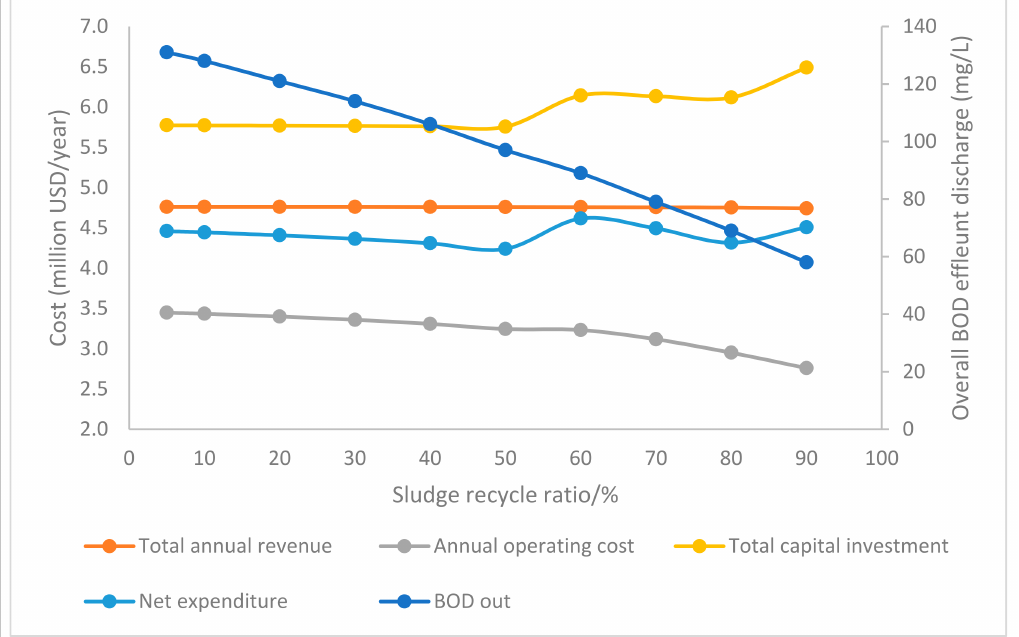
Figure 5. Effect of sludge recycle ratio% on economic feasibility and overall BOD effluent discharge